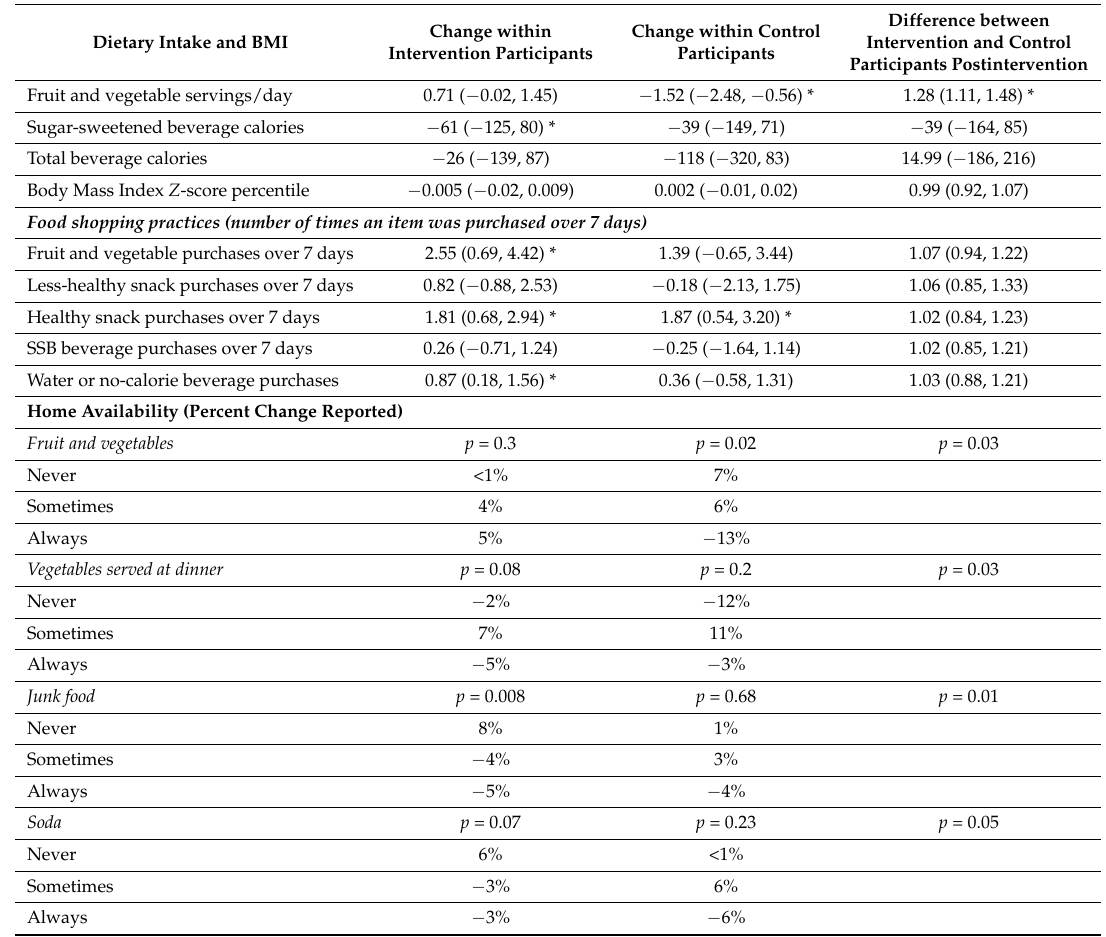
Table 2. Intervention effect of mentor-led text message on dietary intake, food shopping practices, and home availability. Dietary Intake and BMI